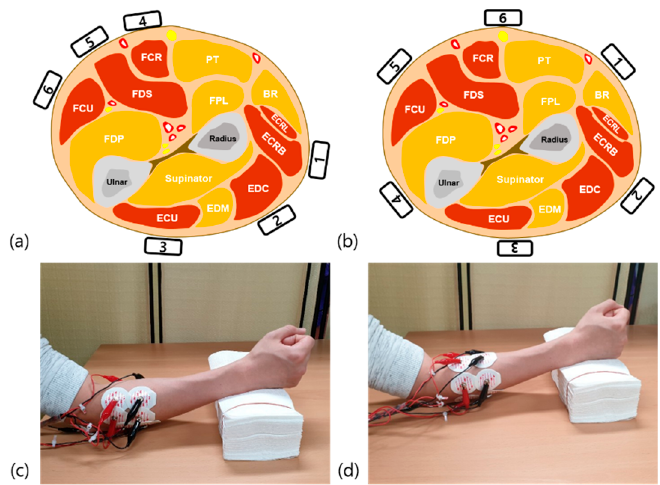
Figure 1. Location of electrodes according to each method. ( a ) Cross section of the right forearm muscle and location of six targeted electrodes. ( b ) Location of six untargeted electrodes. BR: brachioradialis; ECRB: extensor carpi radialis brevis; ECRL: extensor carpi radialis longus; ECU: extensor carpi ulnaris, EDC: extensor digitorum communis; EDM: extensor digiti minimi; FCR: flexor carpi radialis; FCU: flexor carpi ulnaris; FDP: flexor digitorum profundus; FDS: flexor digitorum superficialis; FPL: flexor pollicis longus; PT: pronator teres. ( c ) Electrode placement with targeted method. Six forearm